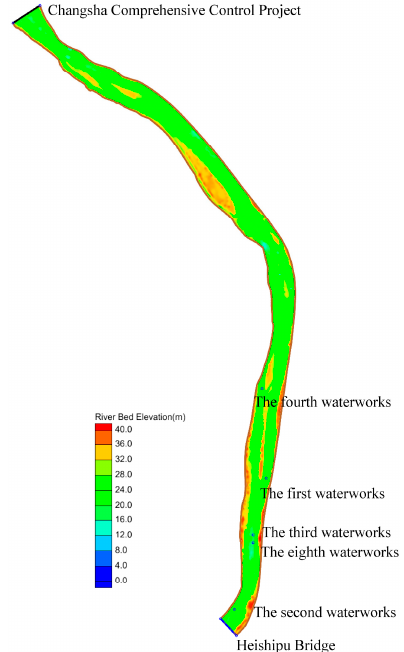
Figure 2. The riverbed terrain of the lower reaches of the Xiangjiang River (from Heishipu Bridge to the Changsha Comprehensive Control Project (CCCP)).